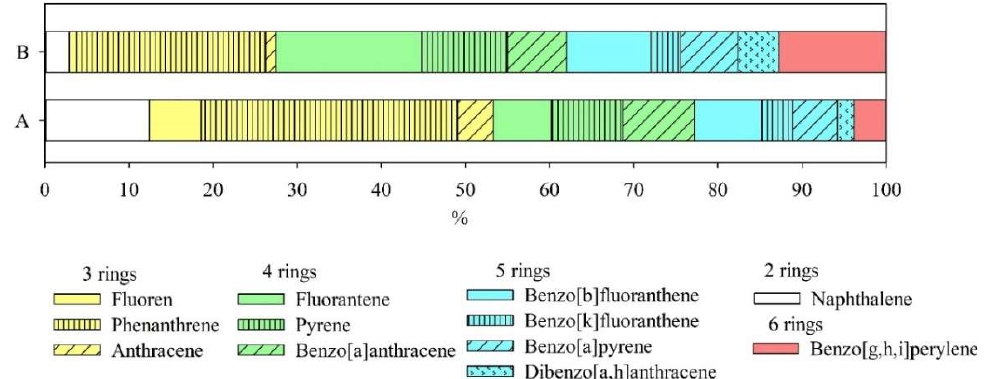
Figure 4. The share of individual PAH compounds from their total content in soils of the monitoring sites A and B.